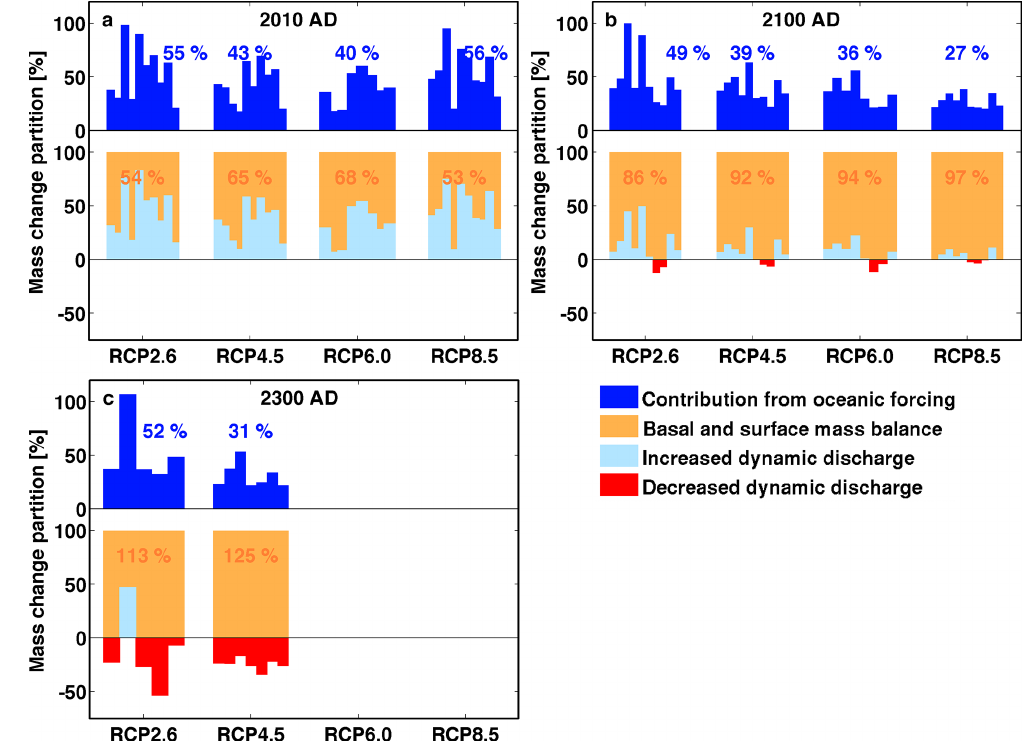
Figure 9. Partitioning of mass changes by 2010 (a) , 2100 (b) and 2300 (c) . Values are given relative to the total ice loss of the individual AOGCM projection and grouped by climate scenario. Each vertical column represents one AOGCM projection. The dark blue columns denote the contribution to the total mass change arising from oceanic forcing, diagnosed from a control run with SMB forcing only. The diagnostics comprise the directly induced ice discharge changes as well as the indirect feedback with the SMB via the ice geometry. The mass change of the projections is subsequently partitioned into contributions from changes in both basal melt and SMB (orange columns) or in ice discharge (light blue and red columns). The presented partitioning of the mass change is cumulative. Changes with respect to the average 1990–2000 values of all contributors in the mass budget are integrated over time. The scenario averages are then given in per cent. At a certain point in the future, ice discharge falls below present-day values and therefore becomes a source term in the mass partitioning. Consequently, the cumulative sea-level contribution from ice discharge changes can become negative